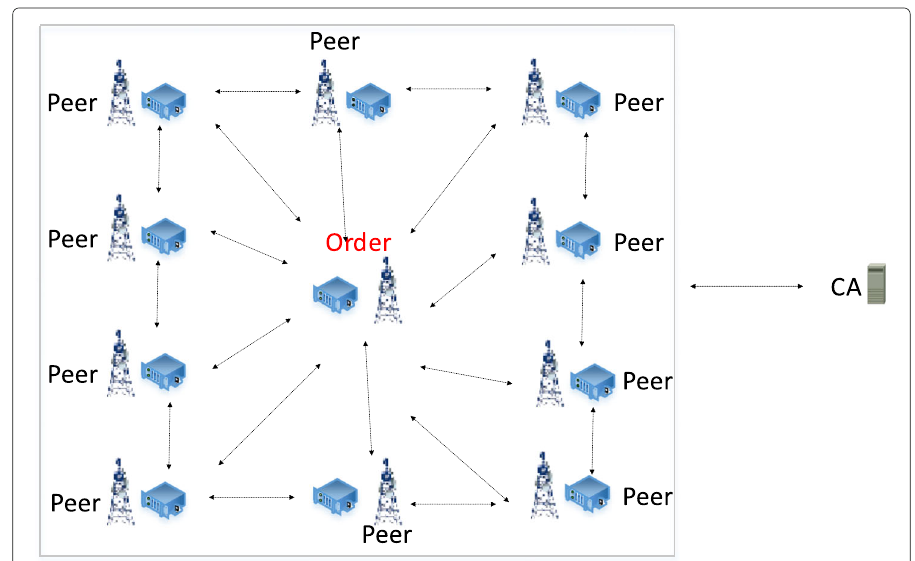
Fig. 7 The building environment of